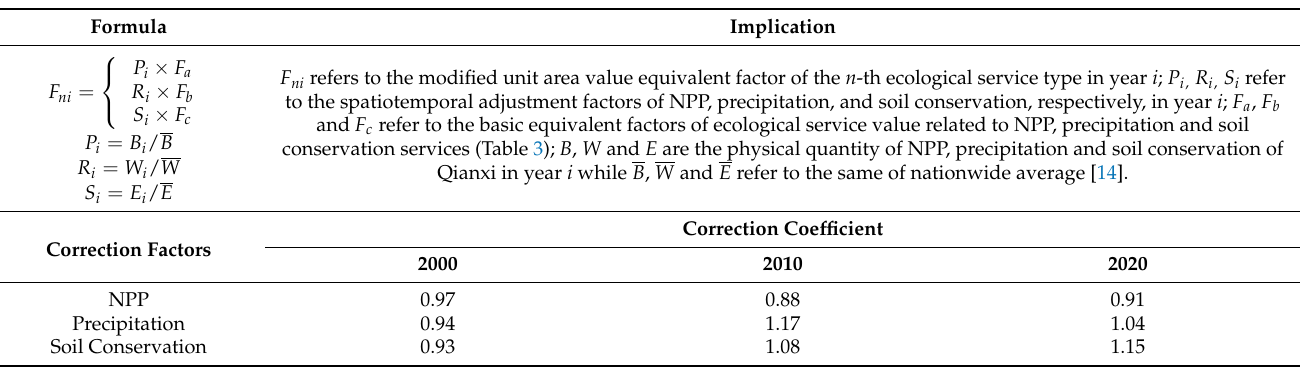
Table 2. Correction models and correction coefficient of equivalent factor in Qianxi